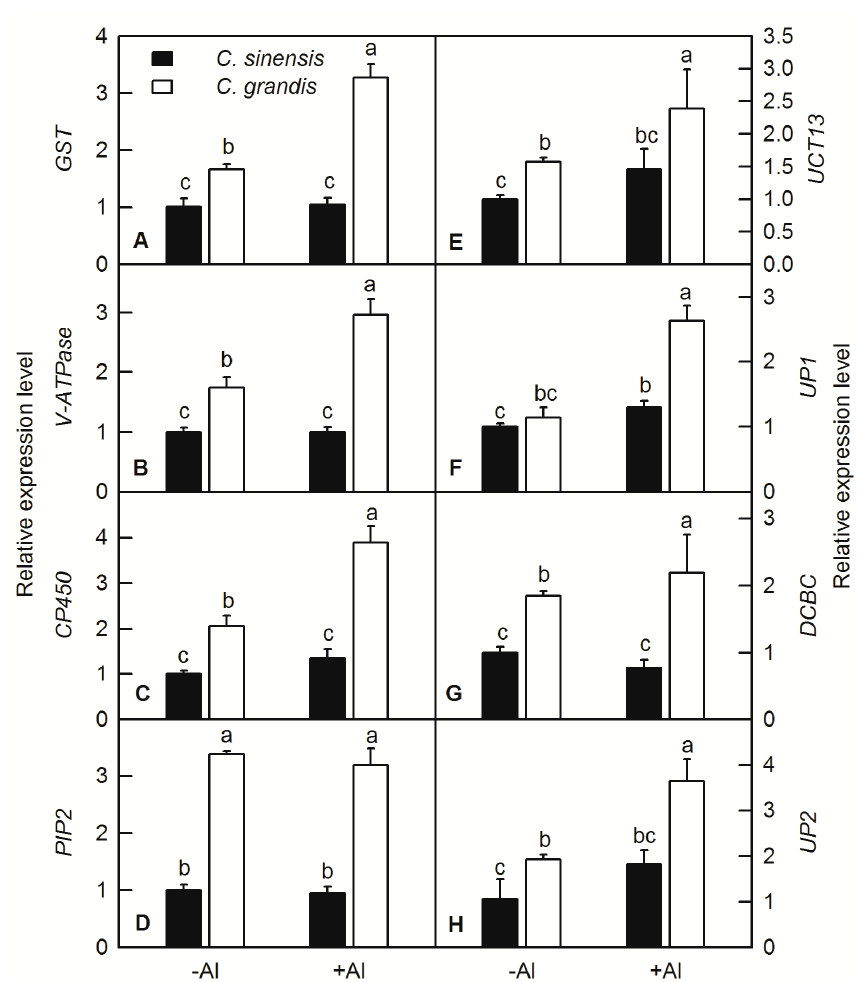
Figure 8. RT-qPCR analysis of the candidated interacting proteins of ALS3 and CAD in citrus roots. GST , glutathione S -transferase ( A ); V-ATPase , V-type proton ATPase ( B ); CP450 , cytochrome P450 ( C ); PIP2 , aquaporin PIP2 ( D ); UCT13 , ubiquitin carboxyl-terminal hydrolase 13 ( E ); UP1 , uncharacterized protein 1 ( F ); DCBC , putative dicyanin blue copper protein ( G ); UP2 , uncharacterized protein 2 ( H ). Bars represent means ± SD ( n = 4). Different letters above the bars indicate a significant difference at p < 0.05.